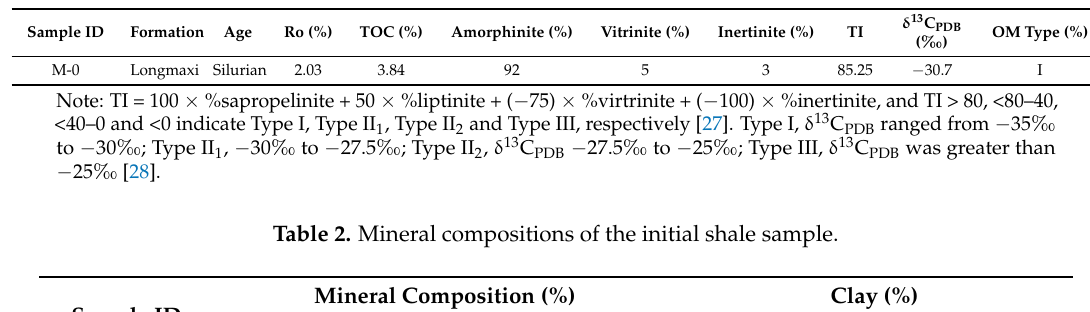
Table 1. The initial shale sample information and geochemical data.